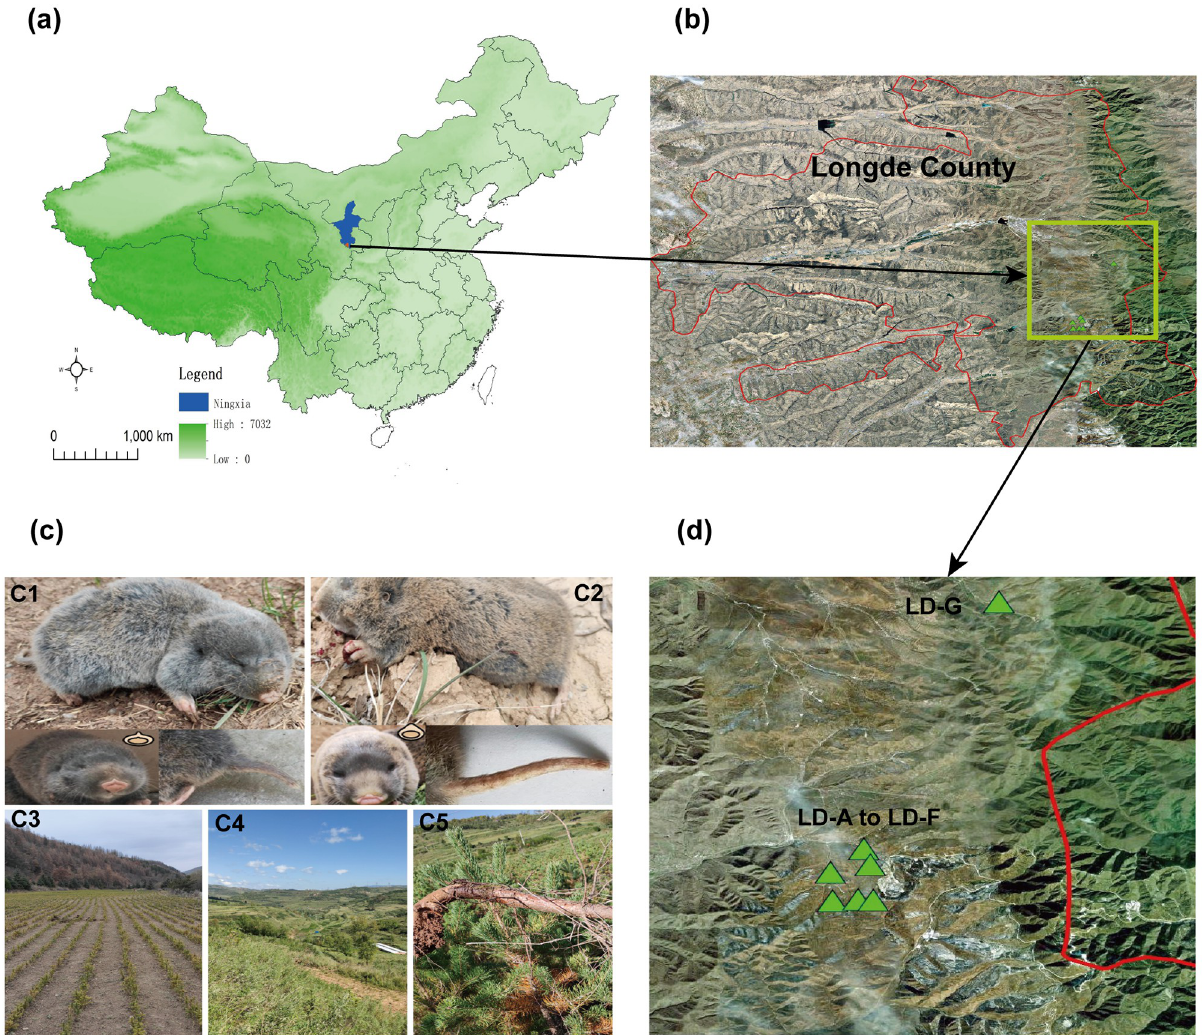
Fig 1. Location and habitat diagram of the study area and map morphological contrast of two zokor species. a . The location of the study area in Ningxia Hui Autonomous Region, China. b . The red line is the county boundary and the green rectangle is the approximate scope of the study area. c . Comparison of the morphology of two species of zokor. 1c1 . E. smithii , coat is taupe, has a short tail with bushy short hairs and an upward spike on the snout; c2 . E. cansus , coat is tawny, has a long tail with sparse short hairs and a smooth upward projection on the snout; c3 . LD-G habitat map; c4 . LD-A to LD-F habitat map. c5 . A root gnawed by the zokors. d . Satellite map of the seven study areas, with green triangles representing study